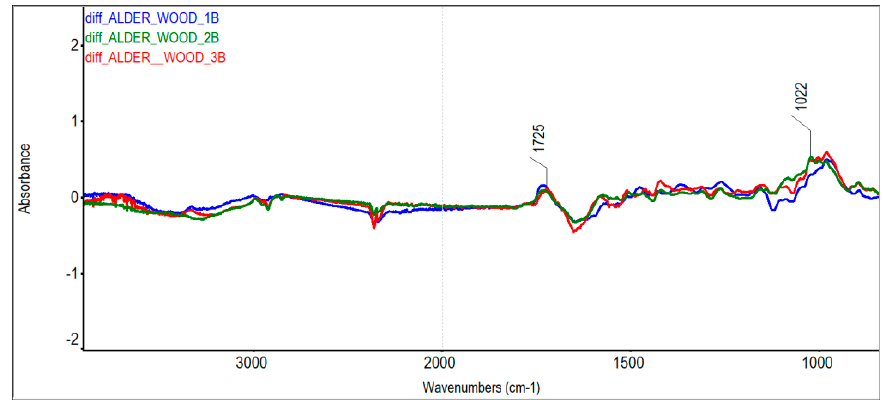
Figure 5. Absorption difference spectra of alder wood after 6 h of thermal modification.